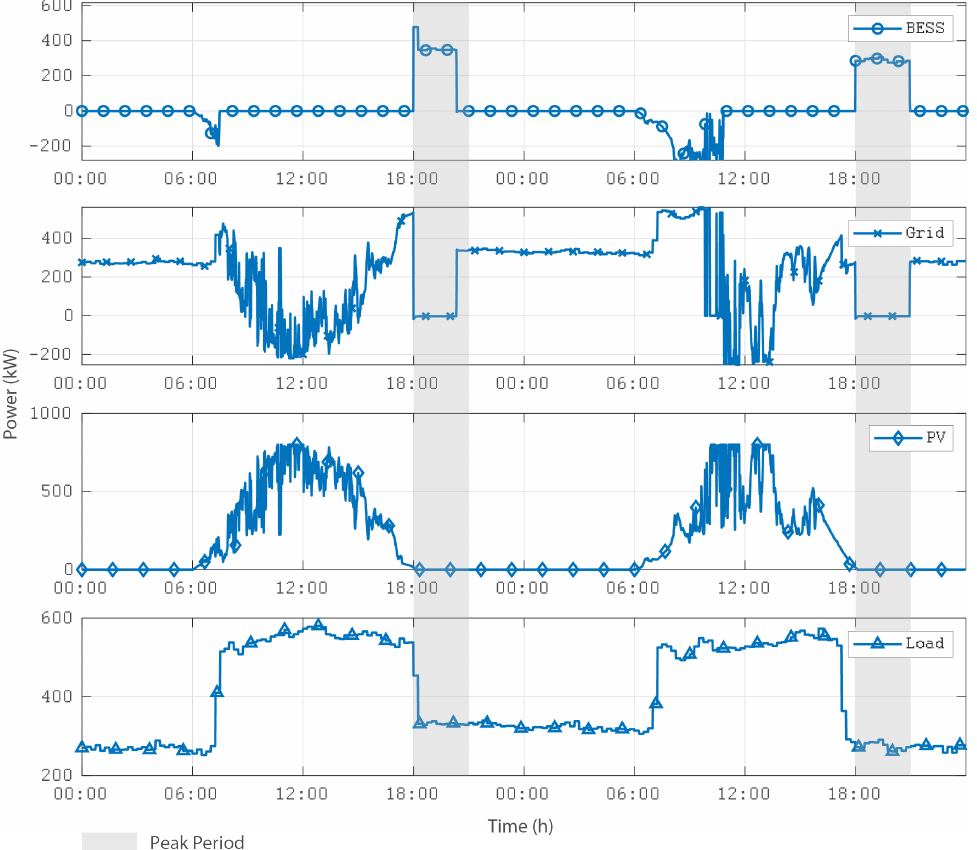
Figure 15. DERs generation and ASC load curves for on-grid